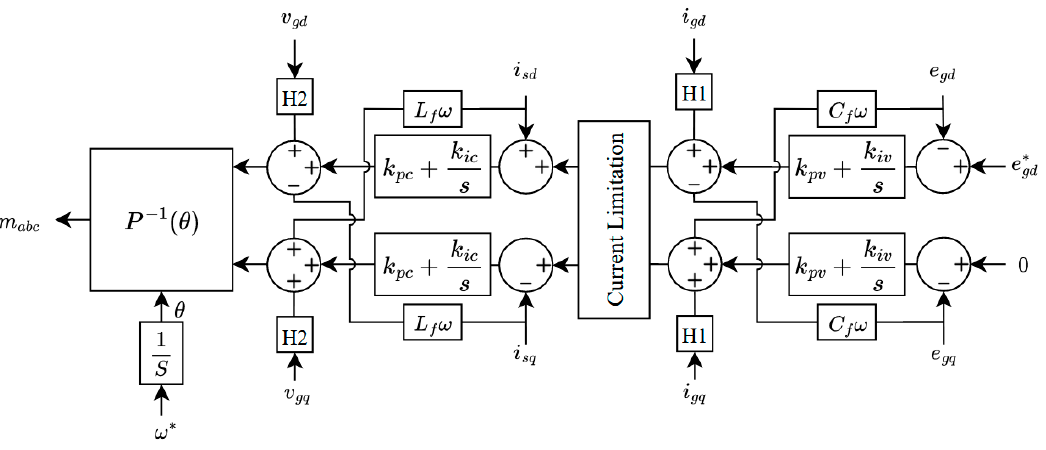
Figure 2. Cascaded control scheme for the grid-forming VSC [21].